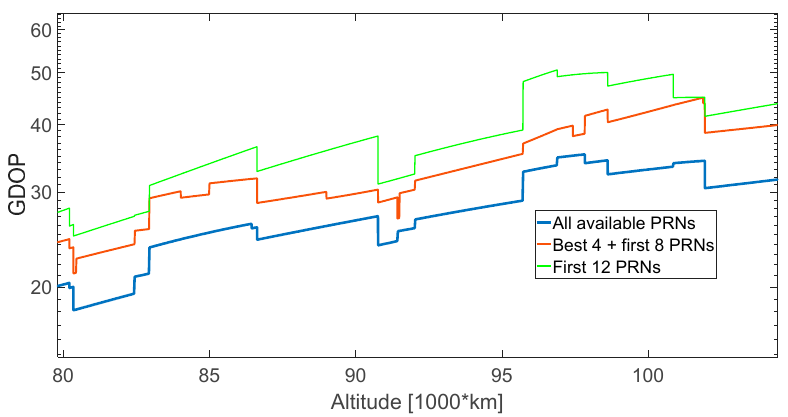
Figure 46. Zoomed-in version of Figure 45 between 80,000 km and 105,000 km.